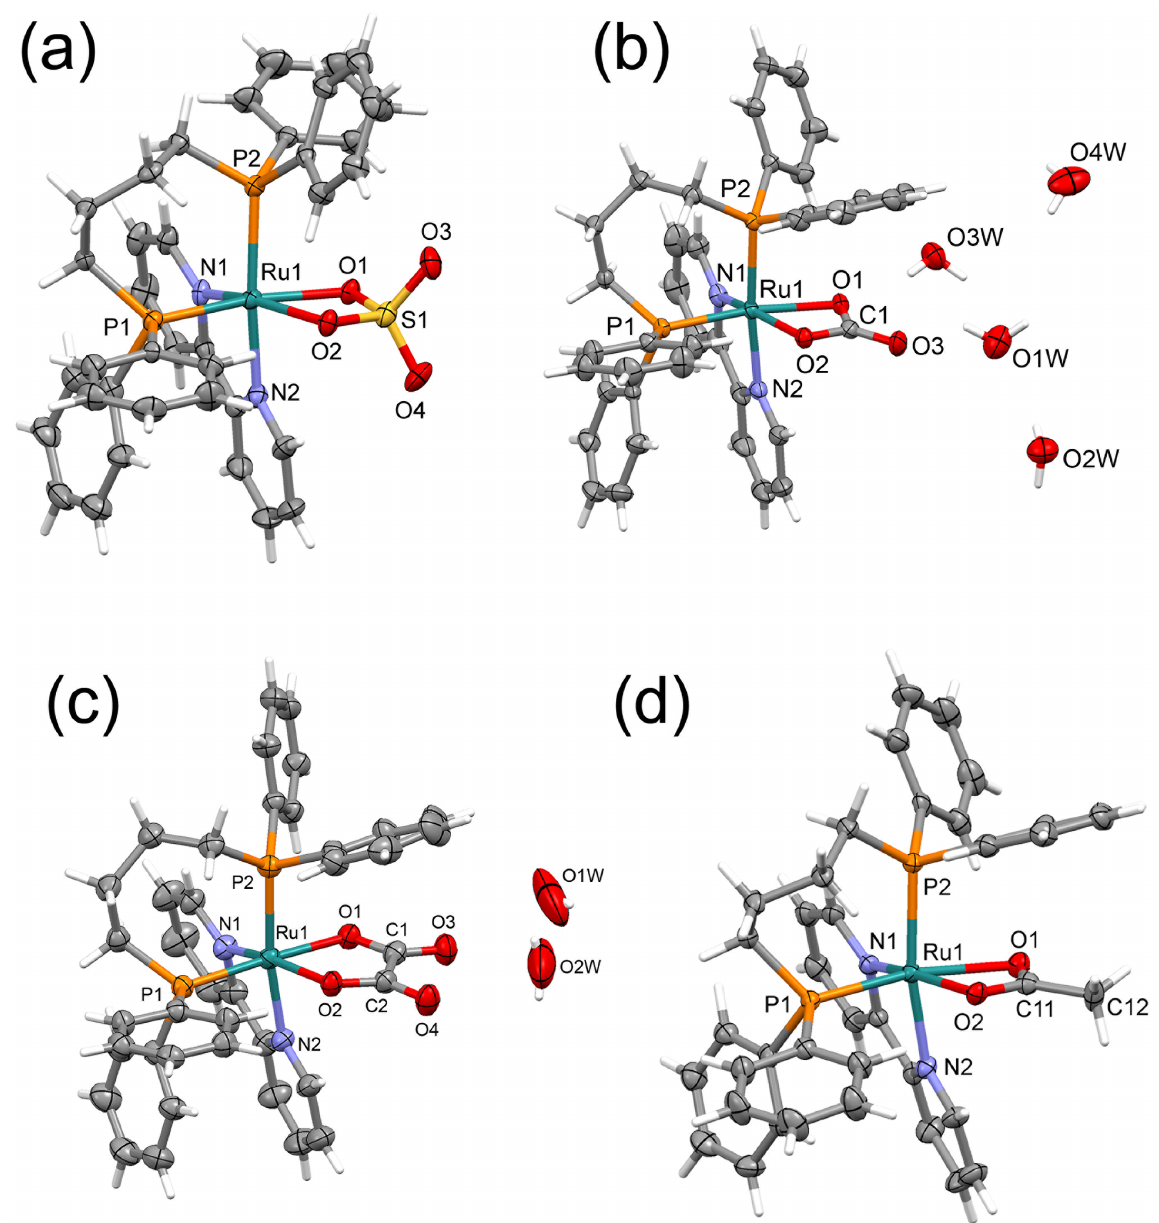
Fig 1. Crystal structures of the complexes. (A) (1) [Ru(SO 4 )(dppb)(bipy)], (B) (2) [Ru(CO 3 )(dppb)(bipy)], (C) (3) [Ru(C 2 O 4 )(dppb) (bipy)] and (D) (4) [Ru(CH 3 CO 2 )(dppb)(bipy)]PF 6 , showingthe atoms labellingand the 30% probabilityellipsoids.For 4, the PF 6- anion was omitted, for sake of